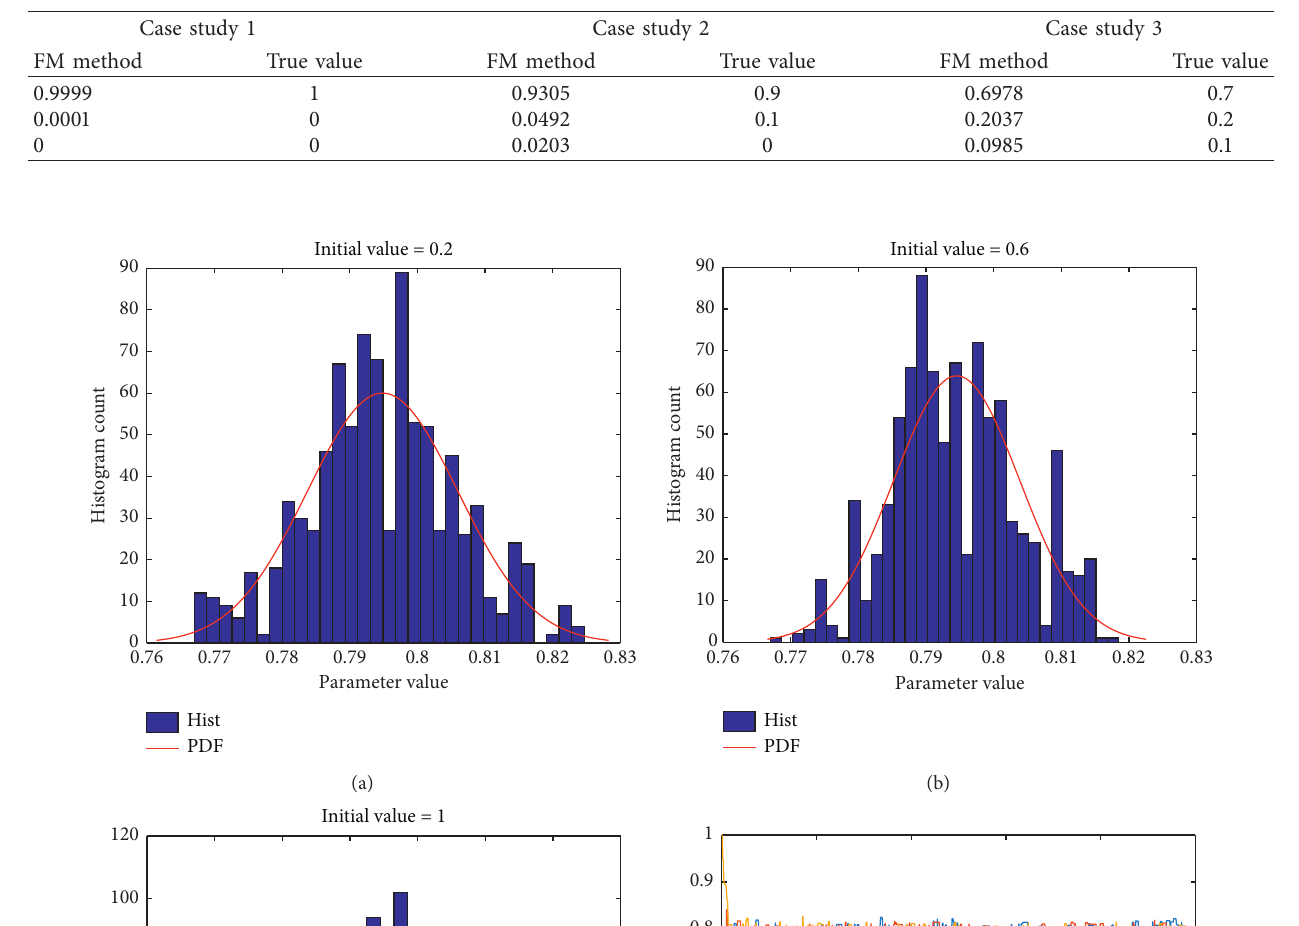
Table 1: Weights in the three cases.